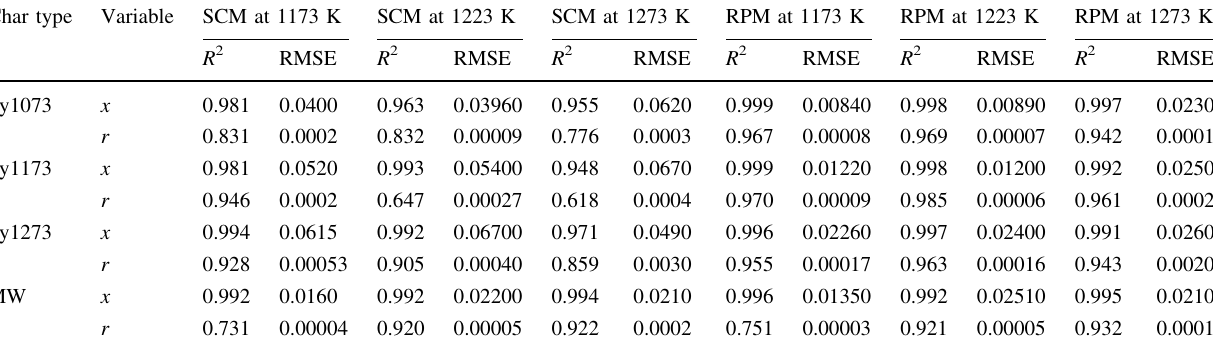
Table 6 Comparison of evaluation indexes based on the SCM and RPM models Char